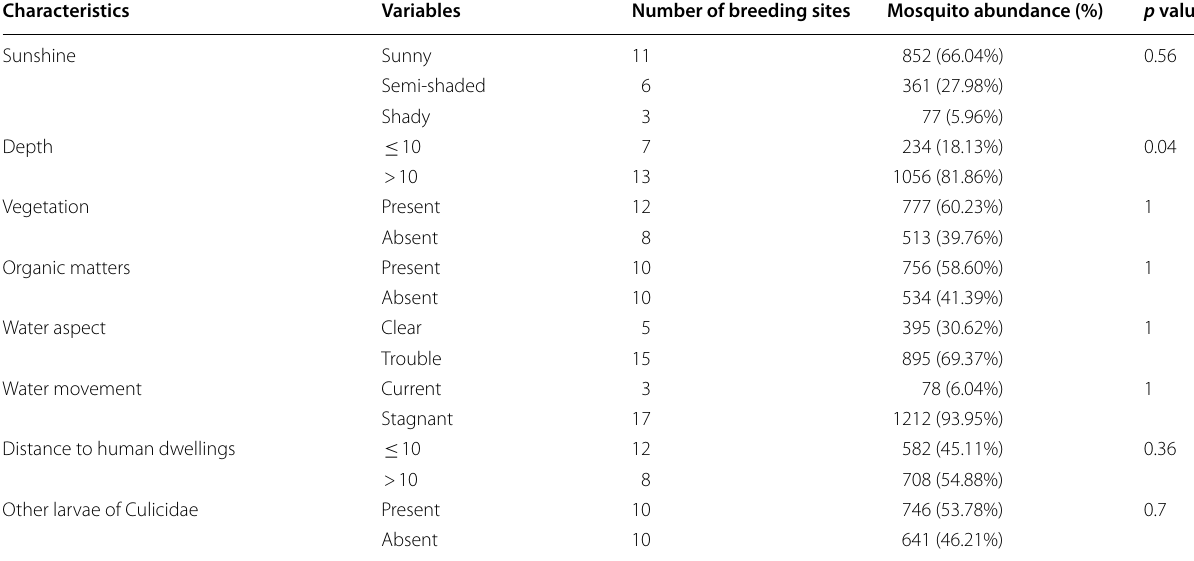
Table 4 Variation of Culex mosquito abundance according to the physical characteristics of breeding habitats in Santchou Characteristics